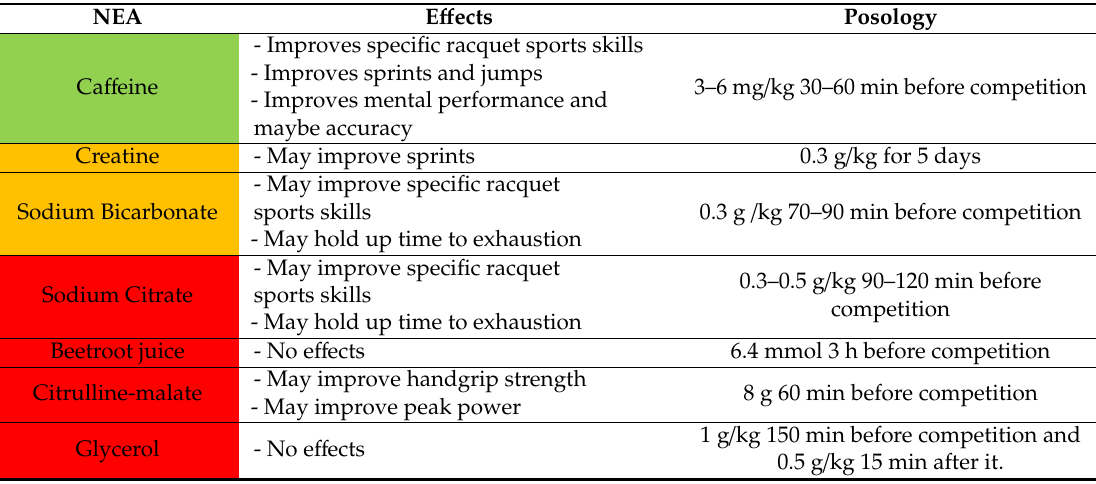
Table 5. NEA recommendations from current evidence. Green: High level of recommendation due to the high number and quality of studies and the e ff ects produced; Orange: Low level of recommendation due to the low number and / or quality of studies and the e ff ects produced; Red: Not recommended due to the low number and quality of studies and contradictory or low e ff